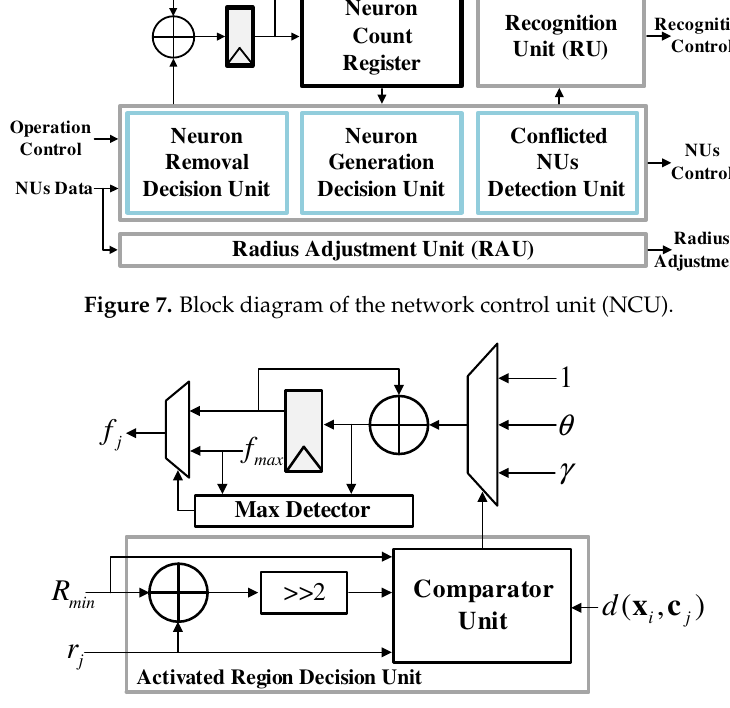
Figure 8. Block diagram of the activation